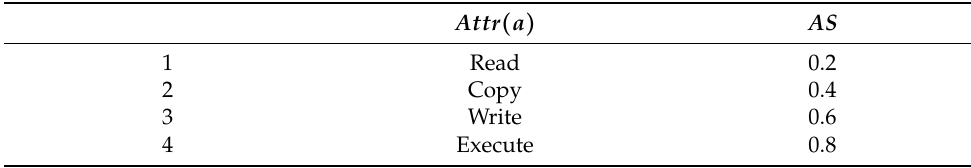
Table 1. Operational Security Sensitivity